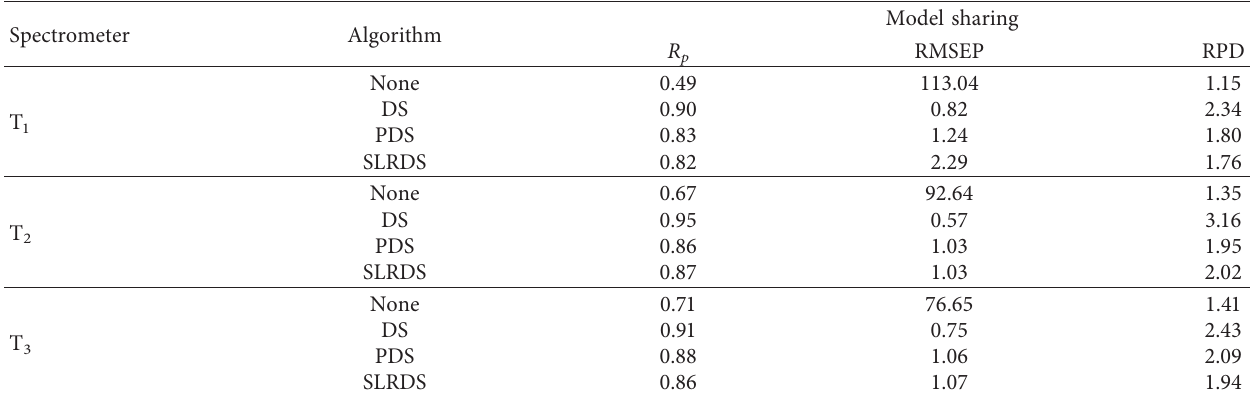
Figure 5: Predictive scatter plot of the crude protein calibration model. (a) Before standardization. (b) After standardization of T standardization of T 2 . (d) After standardization of T 3 . Table 5: Effect of model